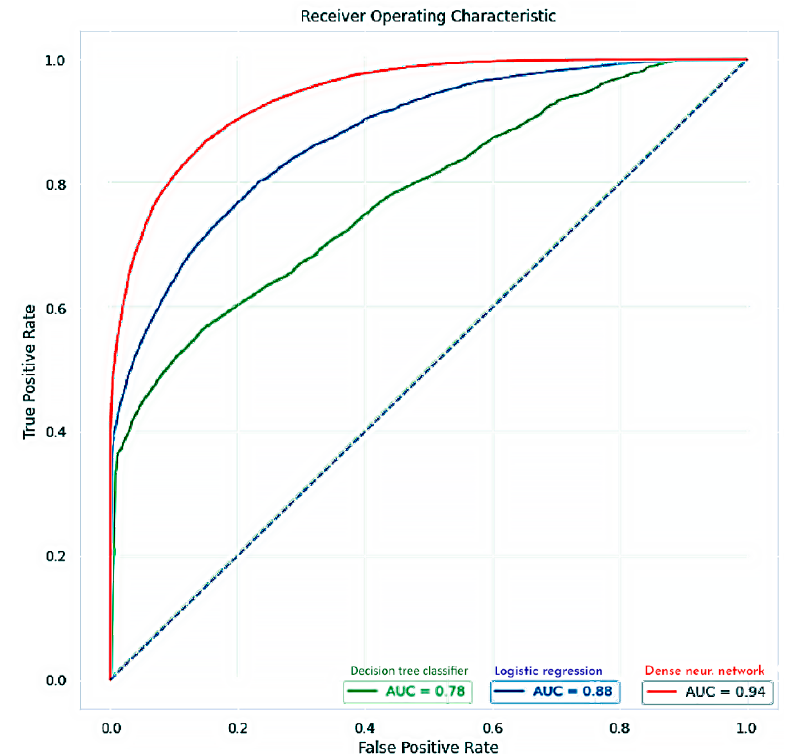
Figure 5. ROC curves of the three systems used for prediction: logistic regression (trained with gradient descent instead or ordinary least squares, marked with blue; AUC = 0.88), decision tree classifier (using the ID3 algorithm, marked with green; AUC = 0.78), and dense neural network (with three hidden layers, marked with red; AUC = 0.94).